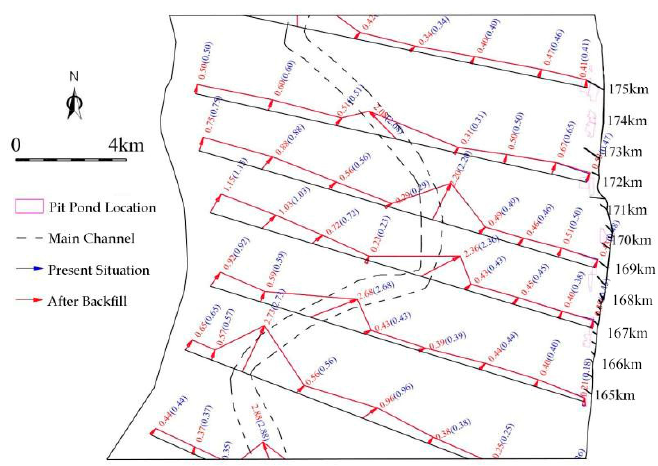
Figure 10. The velocity distribution under the floodplain condition (Q = 22,000 m 3 /s).